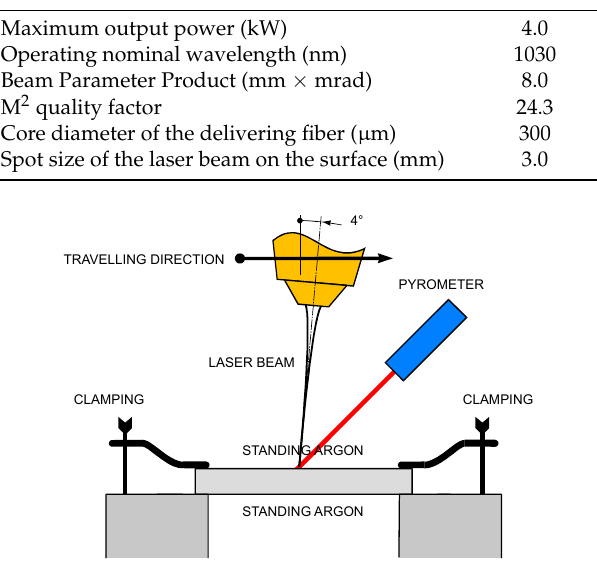
Figure 6. Scheme of the processing set-up; components are not to scale.